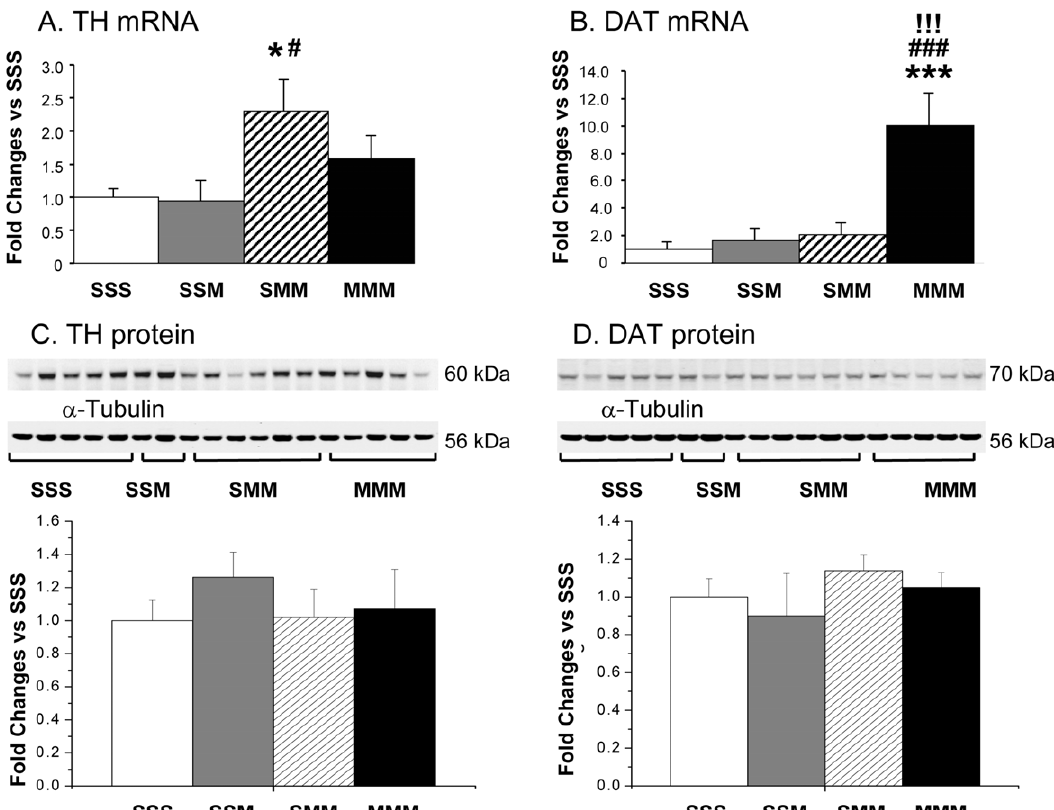
Figure 4. Effect of METH treatment on TH and DAT mRNA and protein levels in the midbrain. METH injections caused increases in TH mRNA only in the saline-pretreated group challenged twice with toxic doses of the drug (A). METH toxic challenges induced increases in DAT mRNA only in METH-pretreated rats (B). Total RNA was obtained from 5–6 animals per group, the mRNA expression was measured individually and normalized to 18S rRNA levels. The METH challenges caused no significant changes in the expression of TH (C) and DAT (D) protein levels. The values represent means 6 SEM in comparison to the saline-pretreated group challenged with saline (SSS group). N=3–5 animals per group. Keys to statistics: *, **, *** p , 0.05, 0.01, 0.001, respectively, in comparison to the SSS group; # , ## , ### p , 0.05, 0.01, 0.001, respectively, in comparison to the SSM group; !, !!, !!! p , 0.05, 0.01, 0.001 respectively, in comparison to the SMM group.